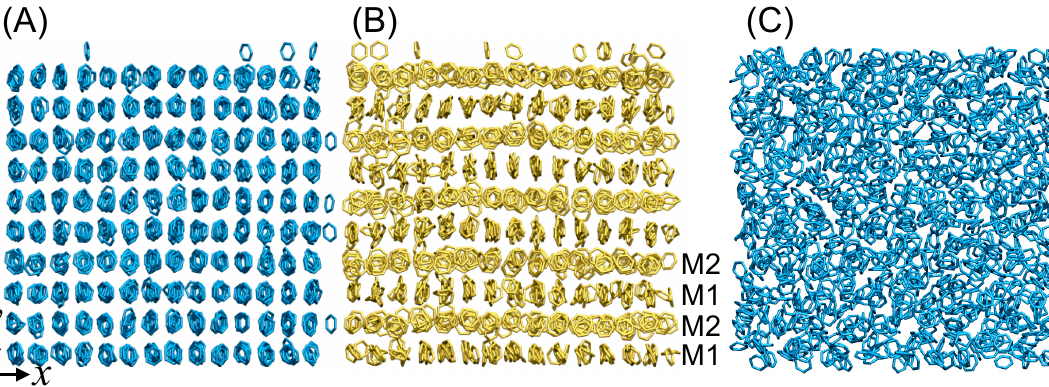
Figure 3. Molecular structures of ( A ) phase I (100 ps), ( B ) metastable phase (490 ps), and ( C ) liquid phase (575 ps). The two distinct layers, M1 and M2, and the y axis are shown in (B).